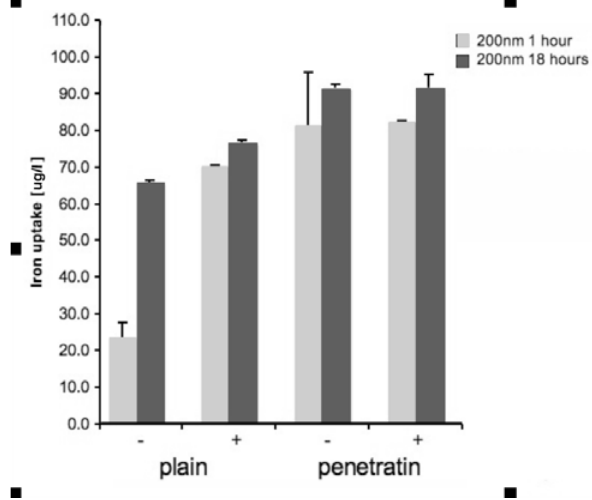
Figure 2. Amount of NP uptake into monolayer cells. Both a magnetic field and the attachment of penetratin significantly increased cellular uptake of the 200 nm NPs (average of n = 5 +/-sd; p < 0.001 for all significant differences described in Section